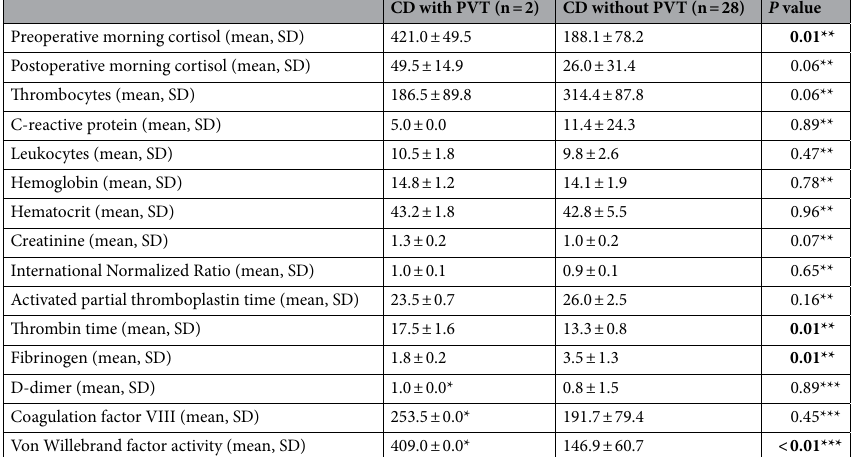
Table 2. Laboratory findings in Cushing’s disease (CD) patients with or without perioperative venous thromboses of the lower extremity (PVT). All values except the postoperative cortisol were obtained preoperatively. Reference range for laboratory results: morning serum cortisol 63.0–181.0 µg/l; thrombocytes 150.0–400.0 billions/l; C-reactive protein 0.0–5.0 mg/l; leukocytes 3.8–11.0 billions/l; hemoglobin 12.3–15.3 g/ dl; hematocrit 35.0–45.0%; creatinine 0.5–1.0 mg/dl; International Normalized Ratio −; activated partial thromboplastin time 25.0–36.0 s; thrombin time 10.3–16.6 s; fibrinogen 2.0–3.9 g/l; D-dimer < 0.5 mg/l; coagulation factor VIII 50.0–150.0%; von Willebrand factor activity 48.8–163.4%. SD standard deviation. *Only one value available. **Mann–Whitney test (two-sided p value). ***Unpaired t test (two-sided p